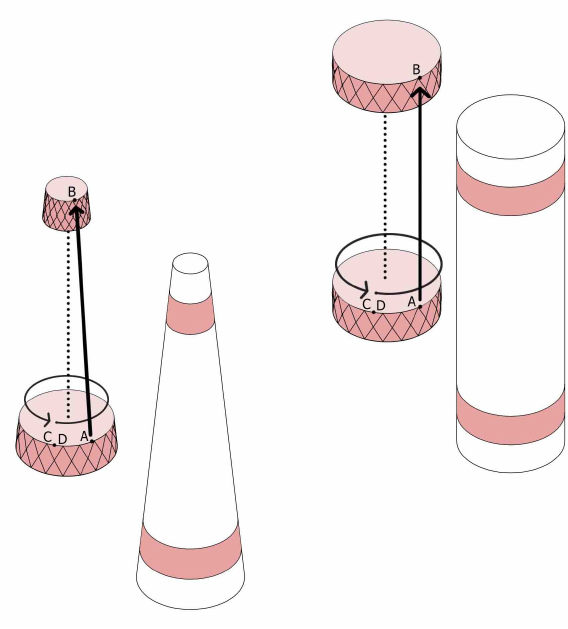
Figure 1: Pattern changes from the bottom to the top; the